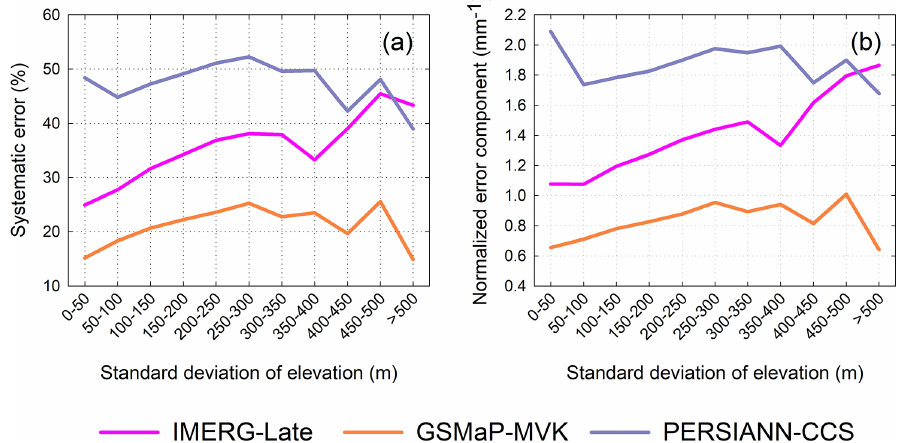
Figure 11. (a) Systematic errors of the three satellite-only global precipitation estimates (i.e., IMERG-Late, GSMaP-MVK, and PERSIANN- CCS) for different topographies; (b) variation in the normalized error component (NEC) of each satellite-only global precipitation estimate with increasing terrain complexity. Note that the analysis was executed at a spatial resolution of 0.1 ◦ and hourly temporal resolution in the humid regions of mainland China over the JJA (summer) season for the period from 2015 to 2019 (5